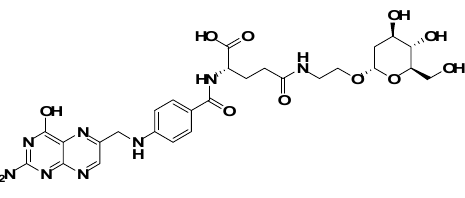
Figure 1. Chemical structure of FA-2-DG.